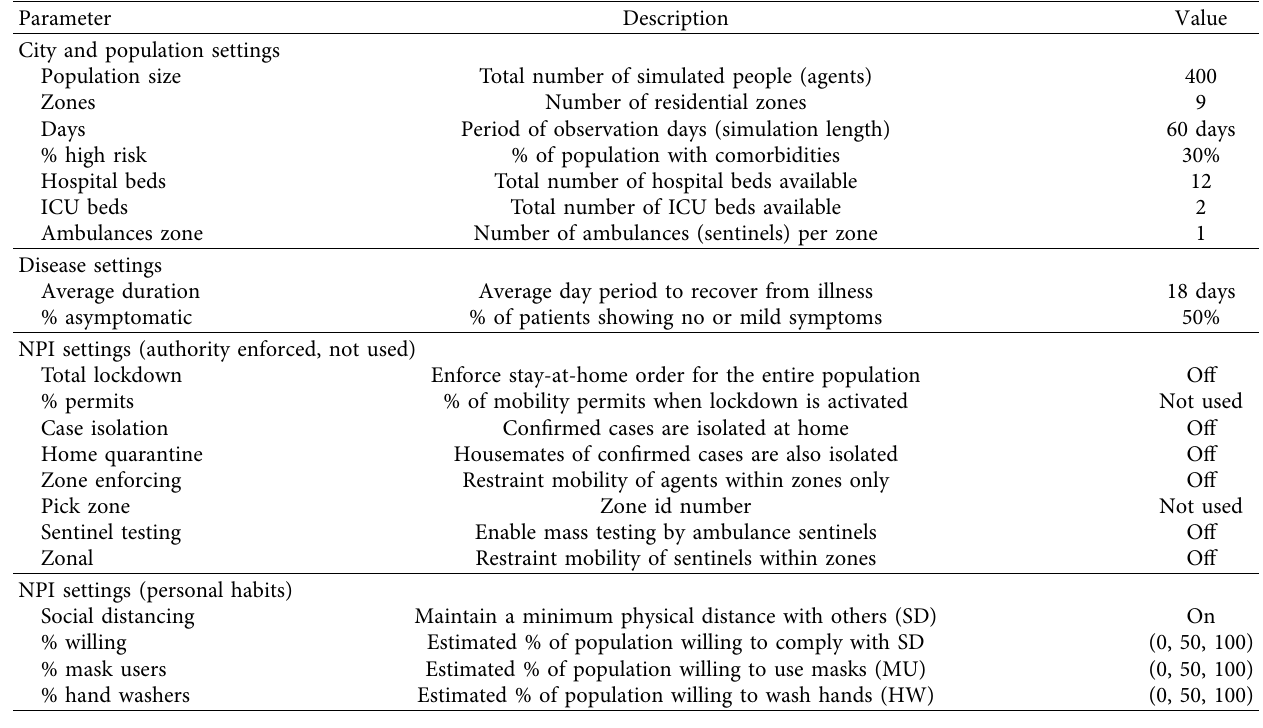
Table 1: Settings used in the simulation tool to perform the